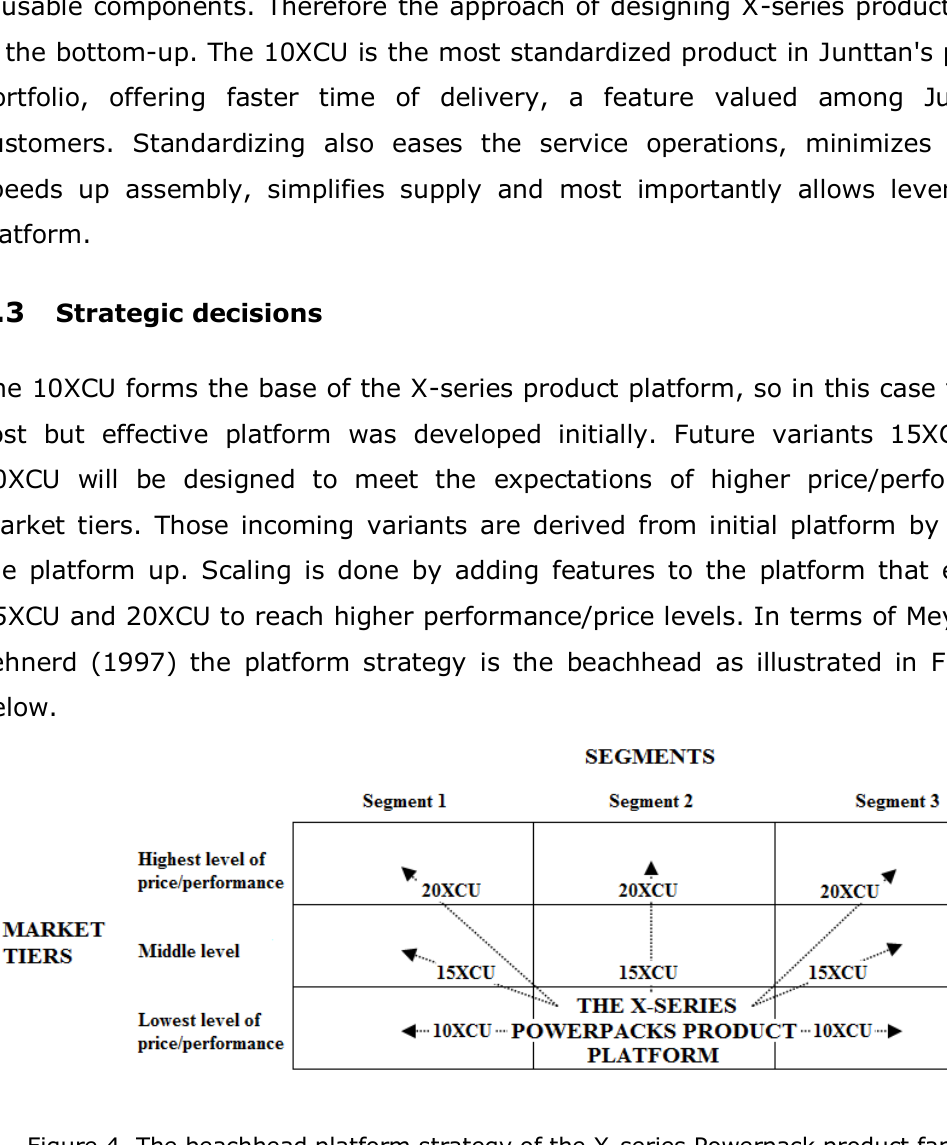
Figure 4. The beachhead platform strategy of the X-series Powerpack product